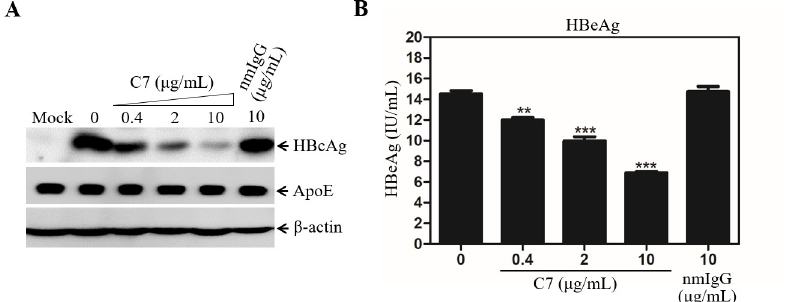
Fig 2. C7 neutralization of HBV infectivity in PHH. PHHs seeded in a 24-well plate were infected with HBV in the presence of 4% PEG and increasing concentrations (0, 0.4, 2, and 10 μ g/mL) of C7 using nmIgG (10 μ g/mL) as a negative control. After 12-hrs incubation at 37˚C, the HBV-infected PHHs were washed with PBS and incubated in Power primary HEP medium with the corresponding concentrations of C7 or nmIgG used during HBV infection. At 4-days post-infection (p.i.), cells were lysed with RIPA buffer. The levels of HBcAg were determined by Western blot analysis ( A ). The levels of HBeAg in the supernatants were quantified by a chemiluminescence immunoassay ( B ). Average levels of HBeAg in the supernatants obtained from triplicate repeats were calculated and plotted against the concentrations of C7. �� P < 0.01, ��� P < 0.001.